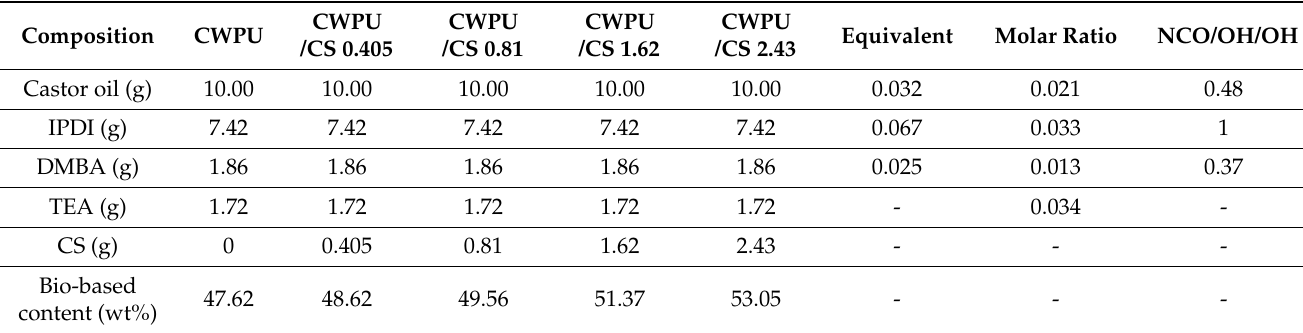
Table 1. Composition of the reactants for CWPU and CWPU/CS nanocomposites with